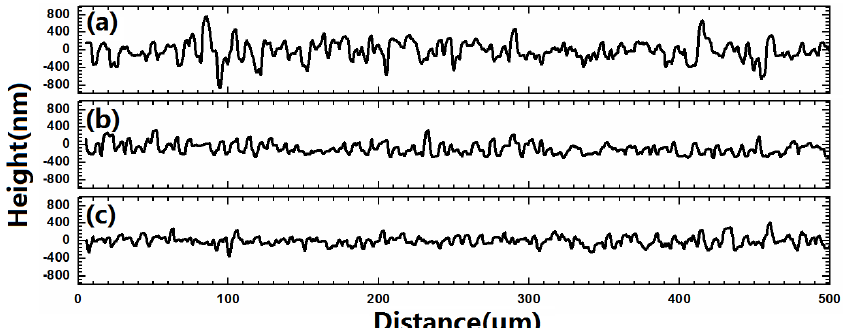
Figure 7. ( a – c ) present the two dimensional surface profiles of the CZTSe films that correspond to Figure 5d–f, respectively.